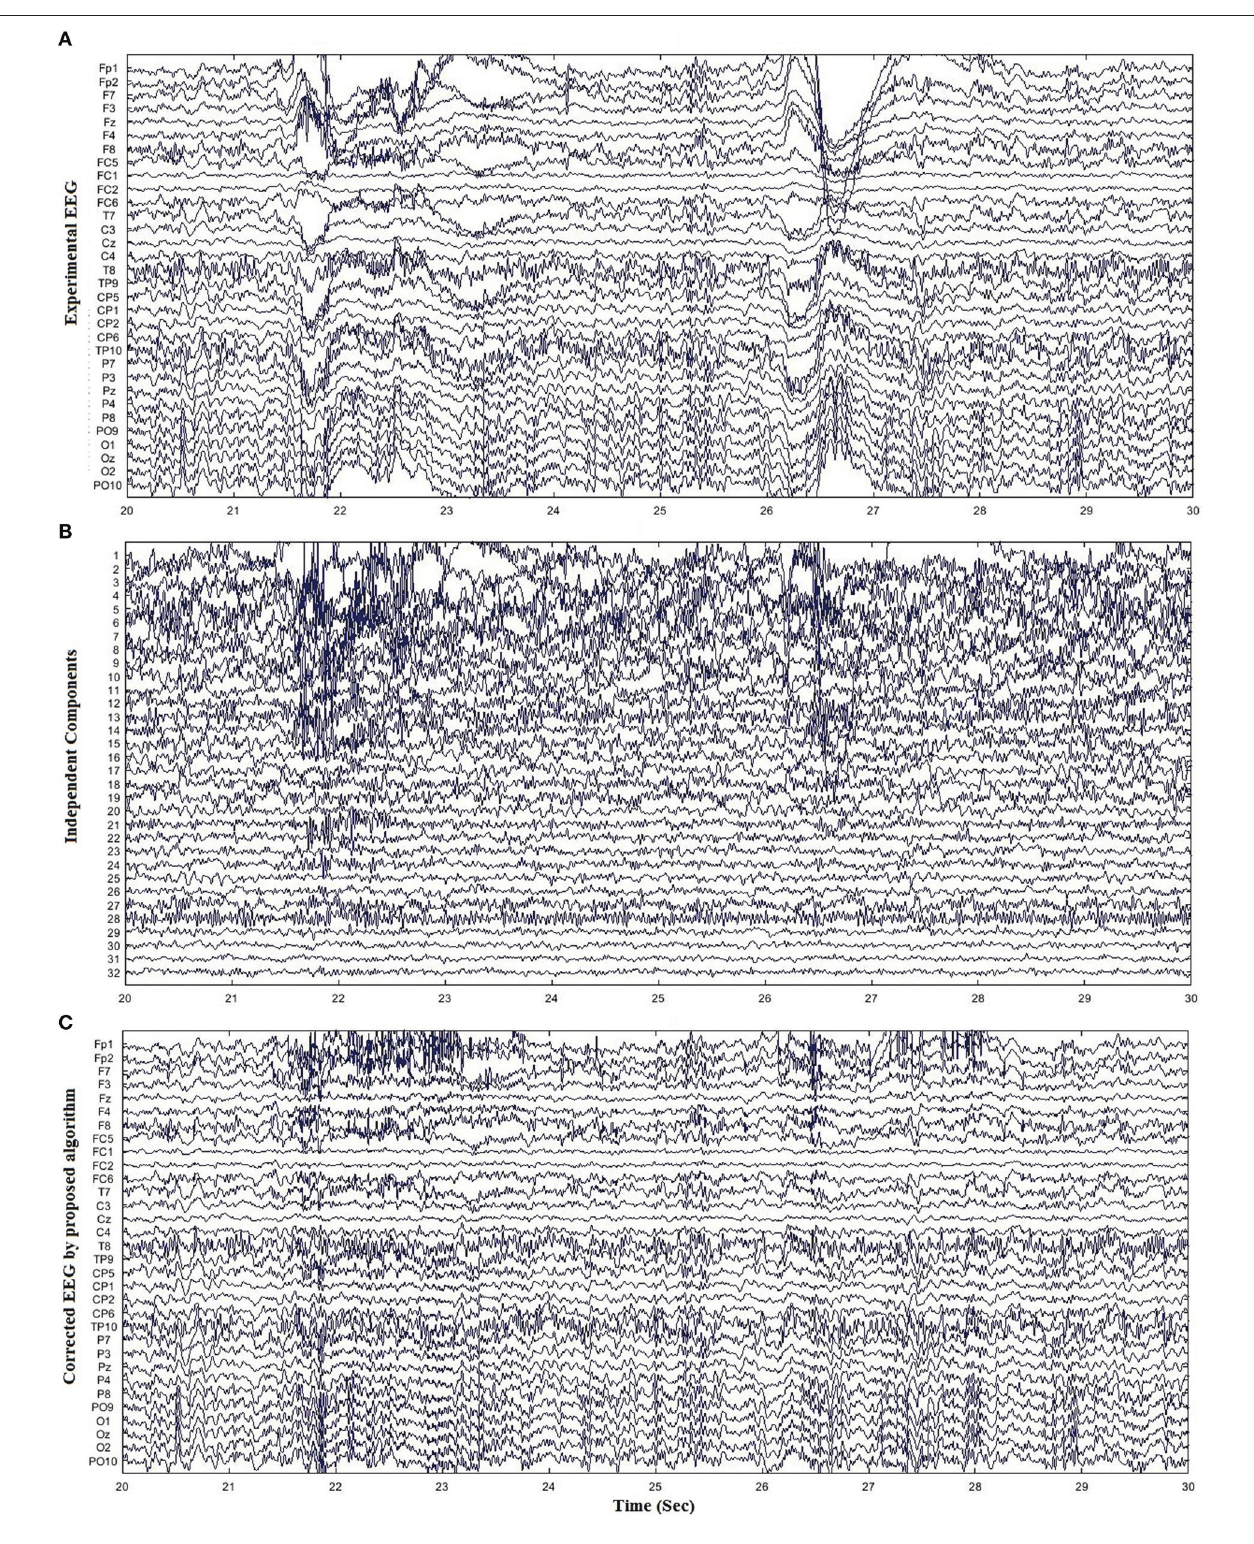
FIGURE 6 | Results for removal of ocular artifacts using experimental dataset. (A) Experimental EEG data for one subject. (B) ICs obtained from ICA decomposition of EEG data. (C) Reconstructed EEG data by the proposed method.